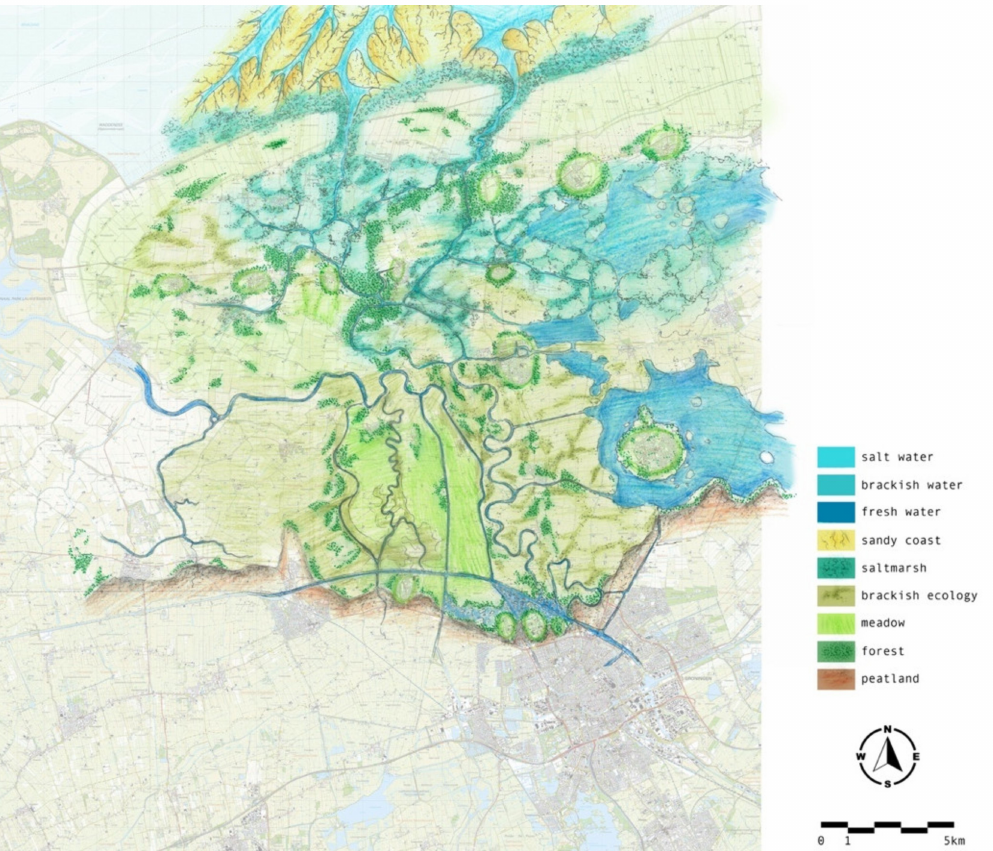
Figure 12. Interplay of ecological landscapes: Tidal flats, salt marshes, wetlands, river forests, brackish creeks, and